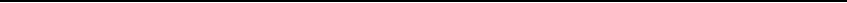
Fig. 5 RNA-seq gene expression analysis of dCas9 3A3L treated and control myoepithelial cells. a PCA analysis of RNA-seq data using all transcripts from early passage (blue), dCas9 3A3L Δ targeted (purple) and dCas9 3A3L targeted (orange) primary myoepithelial cells from donor 1, 10 days post- transfection targeting HIC1 , RASSF1 , PTEN and CDKN2A (including magnetic sorting at day 2). Each circle represents an individual biological replicate ( n = 3). b PCA analysis using only data from transcripts which are differentially expressed between dCas9 3A3L and 3A3L Δ targeted cells as identi fi ed by DESeq2 (p < 0.001; with BH correction); data are shown as early passage (blue), dCas9 3A3L Δ targeted (purple) and dCas9 3A3L targeted (orange) cells. Each circle represents an individual biological replicate ( n = 3). c GO analysis of transcripts which are differentially expressed between dCas9 3A3L and 3A3L Δ targeted cells. GO terms associated with transcripts highly expressed in dCas9 3A3L targeted cells (left panel) and 3A3L Δ targeted cells (right panel) are shown. P value was calculated using Cytoscape (v. 3.4.0) and the add-in package Cluego (v. 2.2.5), which utilises the KEGG pathway database. d , e Gene expression of transcripts associated with d p16 signalling and e p14 signalling from the RNA-seq data 10 days post-transfection in primary myoepithelial cells from donor 1. Data is shown as fold change of gene expression from 3A3L Δ (purple) and 3A3L (orange) compared to average RPKM data from early passage cells (dotted line; mean ± SEM, n = 3). Signi fi cance is from DESeq2 analysis: * p < 0.001 3A3L compared to 3A3L Δ targeted cells;